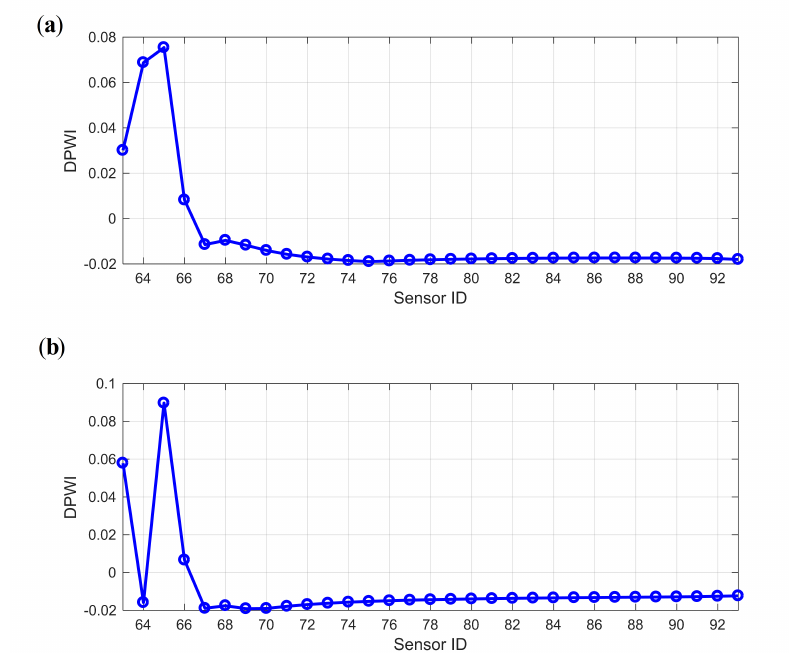
Figure 8. Comparison of DPWIs individually from U x and U y : ( a ) U x ; ( b ) U y